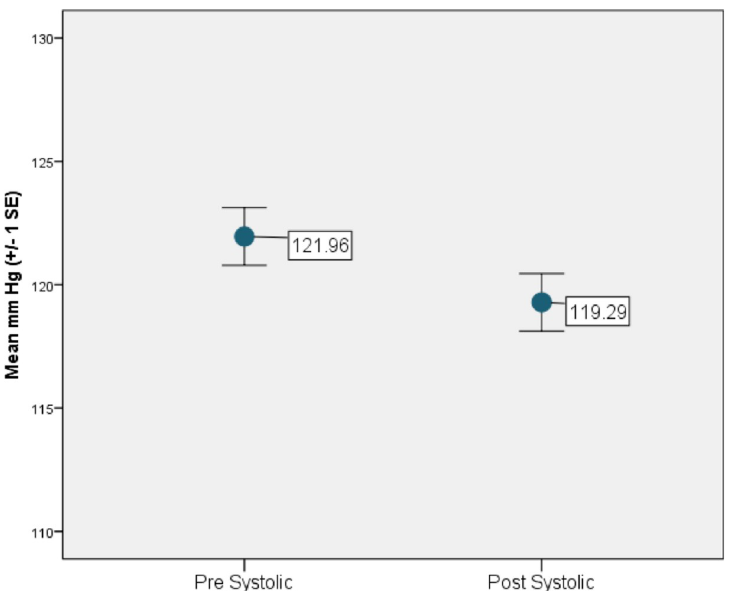
Fig 1. Study participant average systolic blood pressure before and after the River’s Edge experience at the Saint Louis Zoo.